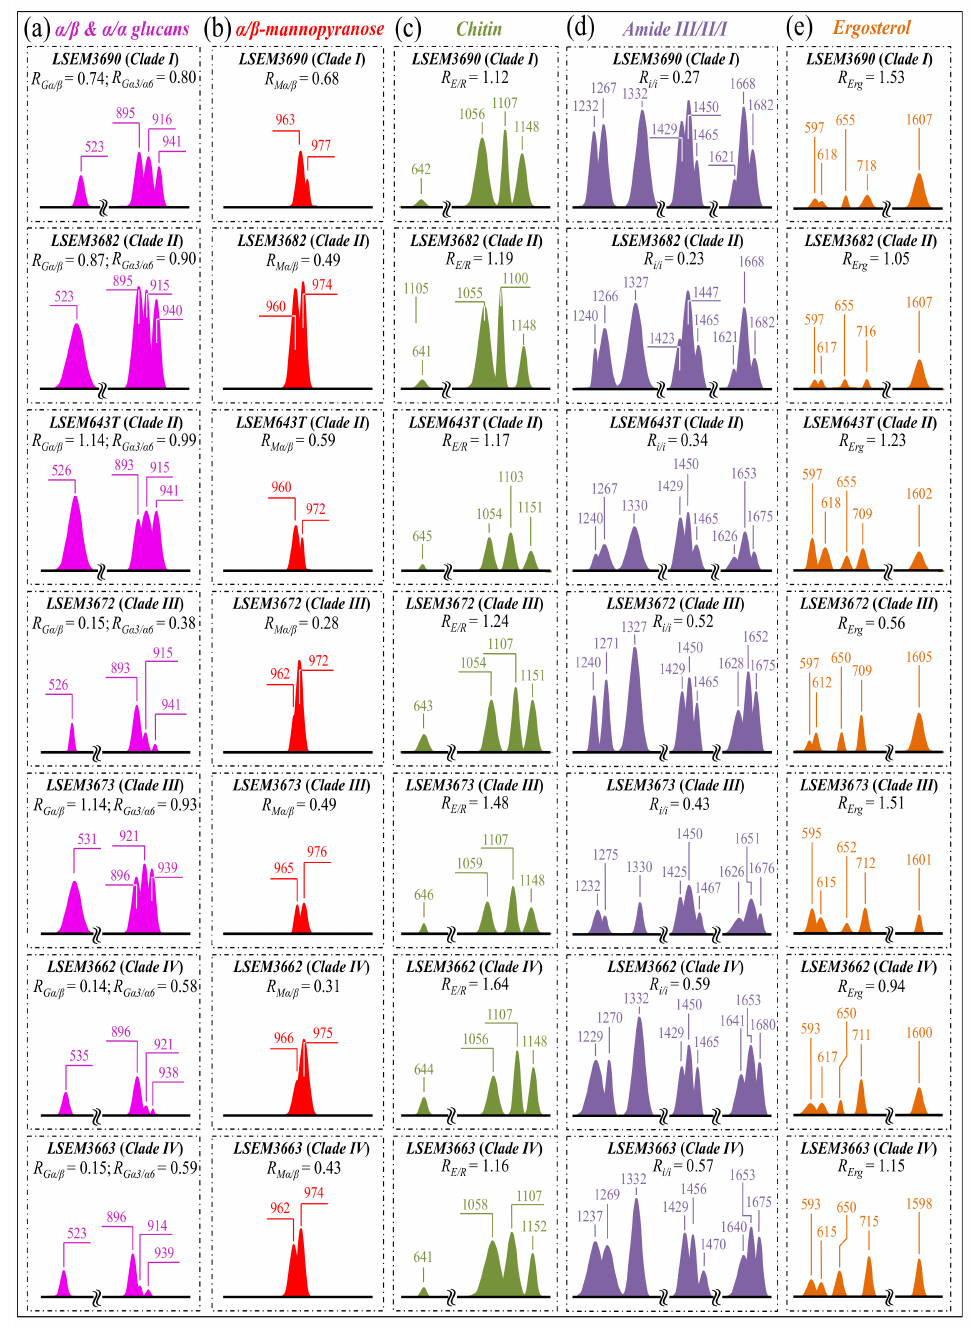
Figure 3. Deconvoluted band components (redrawn from the spectra in Figure 2) for: ( a ) α / β and α / α glucans; ( b ) α / β -mannopyranose; ( c ) chitin; ( d ) amide III/II/I; and ( e ) ergosterol/ergostane. In inset, the computed values are given for the selected Raman biochemical parameters: R G α / β = I 932 / I 890 , R G α 3/ α 6 = I 941 / I 919 , R M α / β = I 960 / I 974 + I 960 , R E/R = I 1107 / I 1054 , R i/i = I 1644 / I 1660 , and R Erg = I 597 / I 620 , respectively. The wavenumbers given in inset are in cm − 1